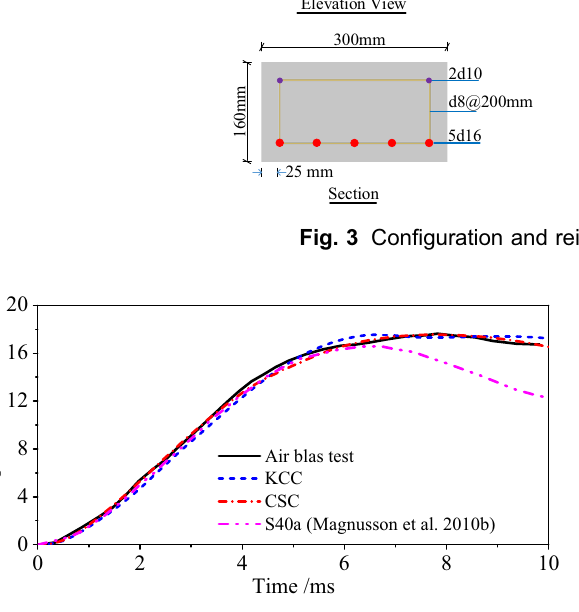
Fig. 4 Comparison of the mid-span displacement time